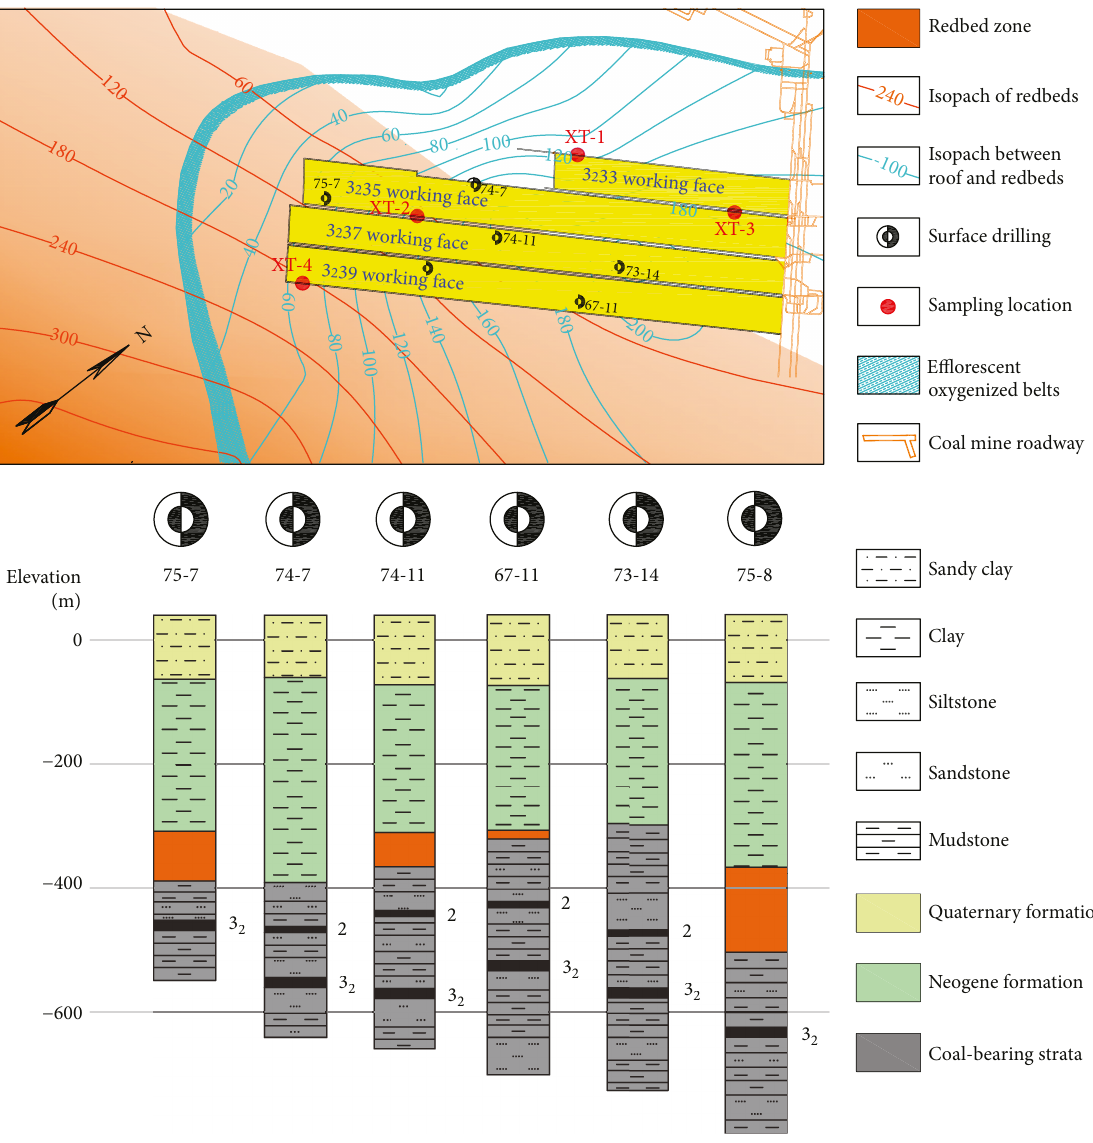
Figure 2: Distribution map of sampling